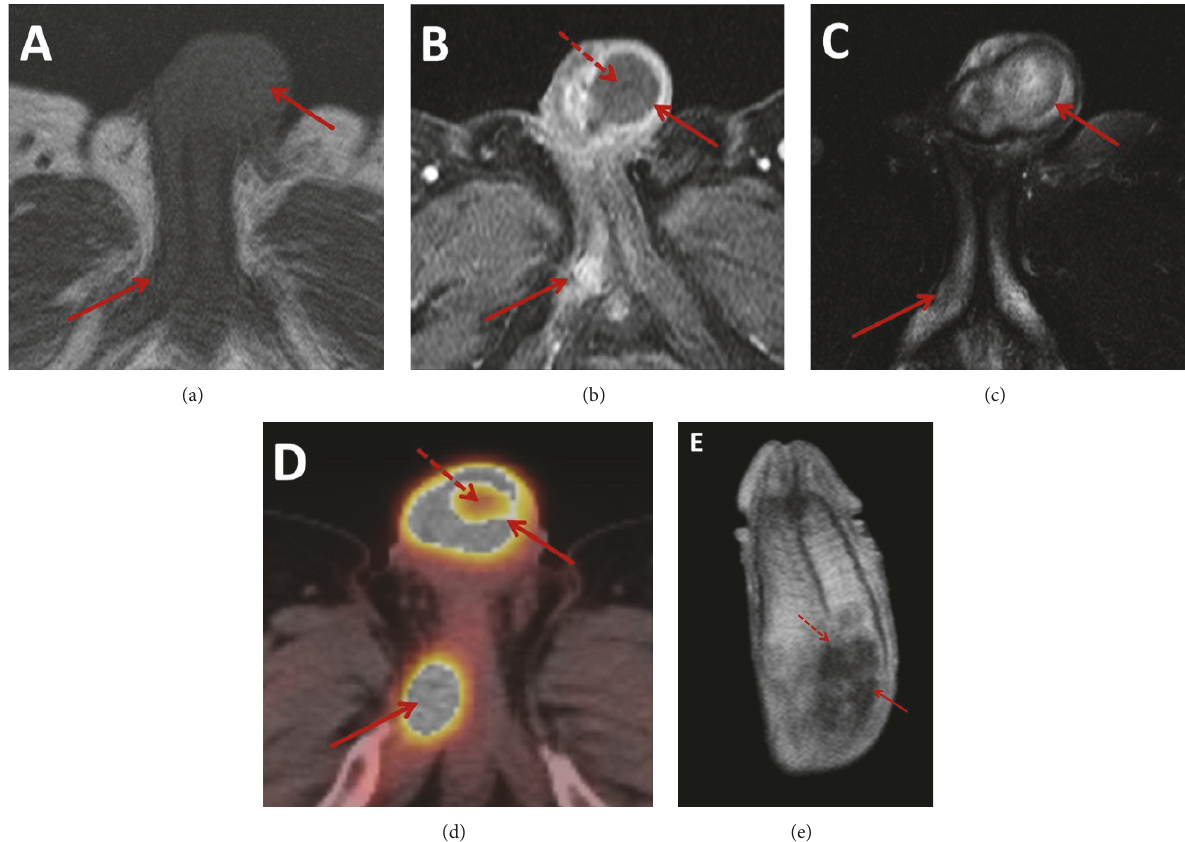
Figure 1: Axial T1-weighted MR images (a) demonstrate two isointense penile masses involving the left paracentral shaft base and proximal right corpus cavernosum (solid arrows) demonstrated with enhancement (solid arrow) on axial contrast enhanced T1-weighted MR images (b). The larger lesion at the base of the shaft demonstrates peripheral enhancement and central nonenhancement (dashed arrow), while the smaller posterior lesion homogeneously enhances. Both lesions demonstrate intrinsic heterogeneous hyperintensity (solid arrow) on axial T2-weighted MR imaging (c). Corresponding to the areas of enhancement on postcontrast MR images, PET/CT imaging (d) demonstrates hypermetabolic activity (solid arrow). A central area of decreased metabolic activity within the larger lesion (dashed arrow) corresponds to the area of central nonenhancement on MRI in keeping with central necrosis. Coronal contrast-enhanced T1-weighted MR image (e) demonstrates the larger lesion (solid arrow) extending across the intercorporal septum (dashed